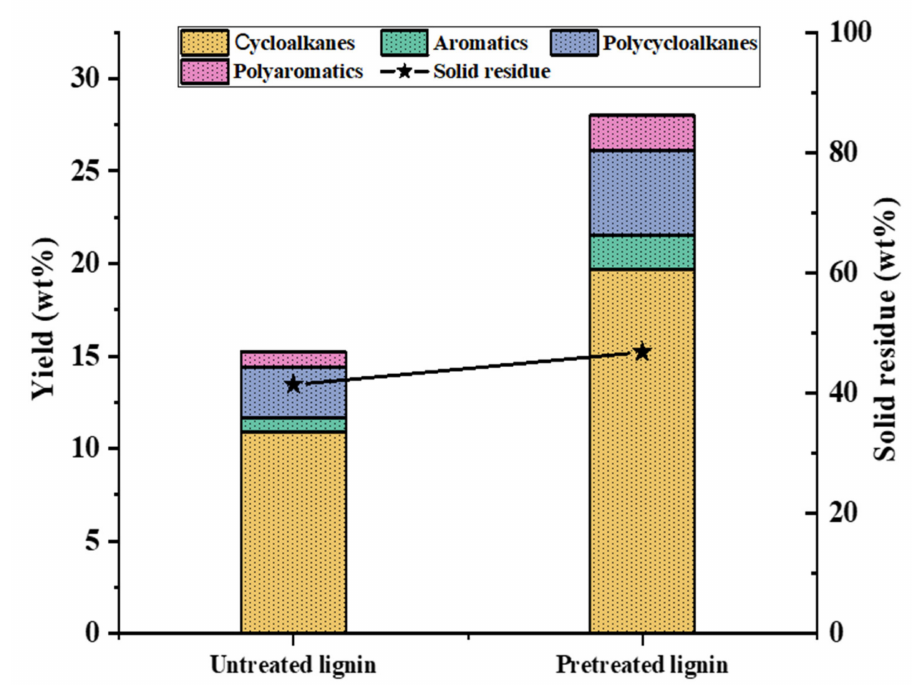
Figure 6. Product yield and solid residue obtained with untreated and pretreated lignins over the NiMoS/Al 2 O 3